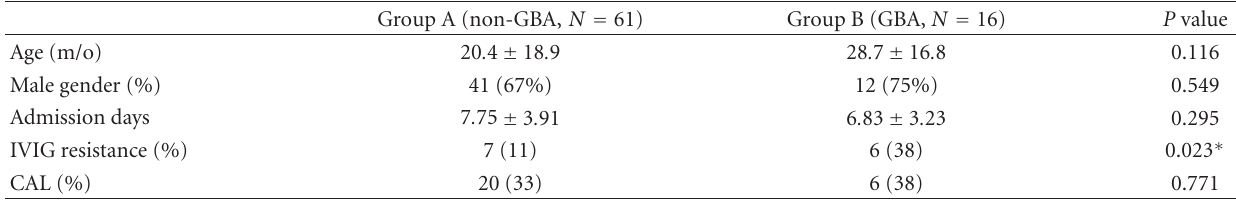
Table 1: Characteristic of gallbladder abnormalities (GBAs) and non-GBA in Kawasaki disease patients.